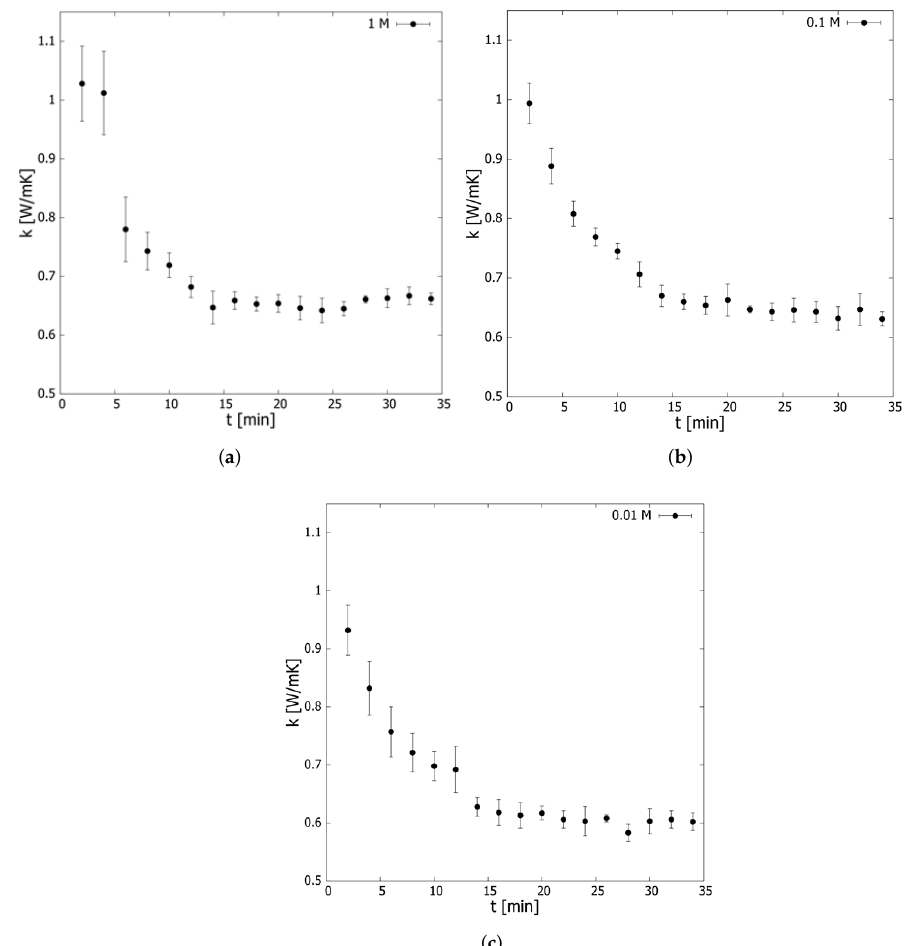
Figure 3. Transient thermal conductivity of nanofluids using rGO/Ag prepared with ( a ) 1.0 M, ( b ) 0.1 M, and ( c ) 0.01 M Ag. The error bars correspond to the measurements’ standard